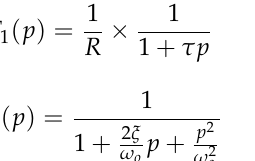
PI Voltage Figure 4. Synoptic of the imbalance voltage compensation loop. 3. Digital Phase-Shift Self-Oscillating Current Controller 3.1. PSSOCC Model Inaccuracy Studies presented in [24,25] investigated the accuracy of the PSSOCC controlling the output current of a DC/AC converter. A main result of those works is that there is an important error between the theoretical value of the maximum oscillation frequency and the maximum switching frequency observed in practice, especially in case the maximum switching frequency targeted is pretty high. This error of the model is clarified with Fig- ure 5 depicting the input current spectrum of a single-phase Vienna converter controlled by PSSOCC.